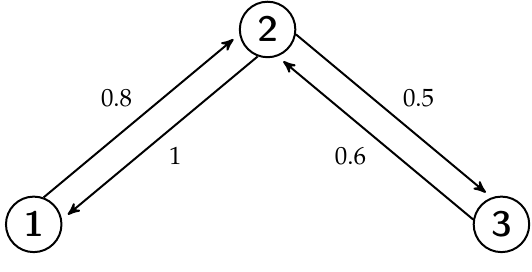
Figure 2. Communication topology.